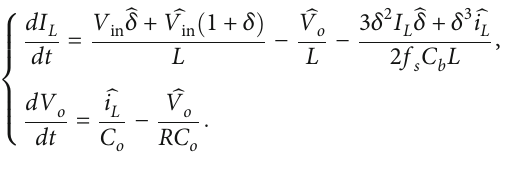
using (a) HPC and (b) PID controller. i